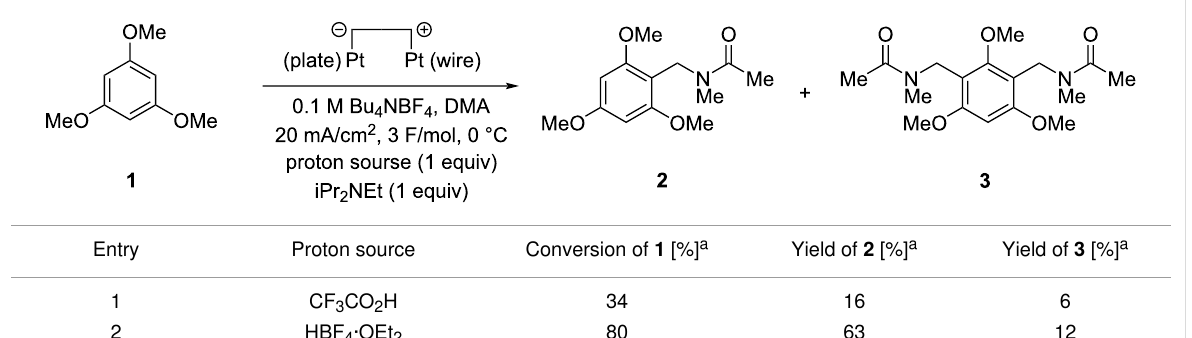
Table 1: Effect of the proton source in electrochemical